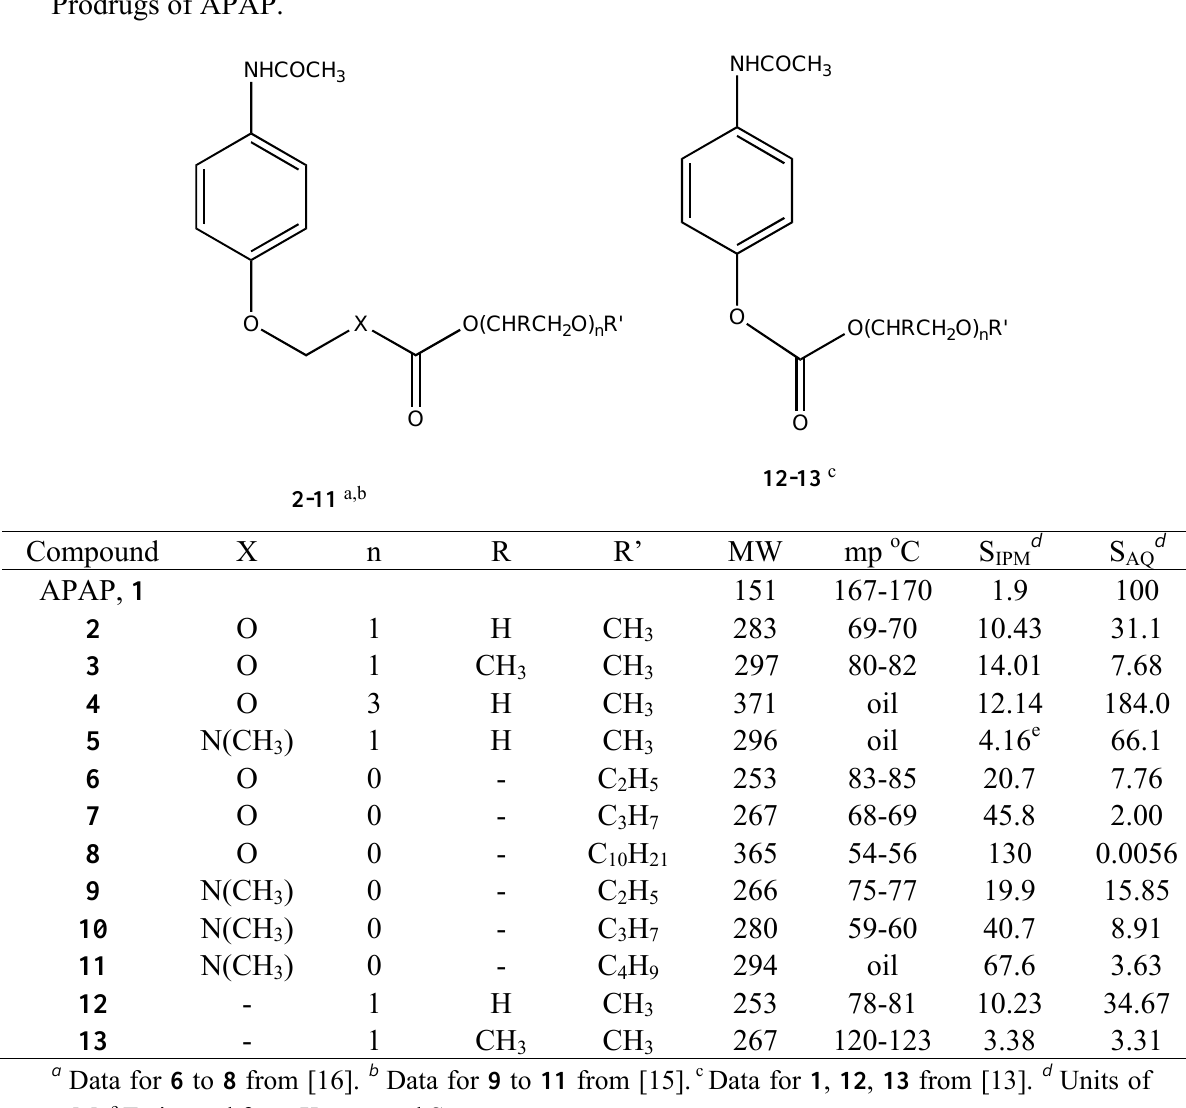
Table 1. Physicochemical Properties:Molecular Weight (MW), Melting Point (mp), Solubility in IPM (S ), Water Solubility (S ) of AOCOM, NANAOCAM and AOC IPM AQ Prodrugs of